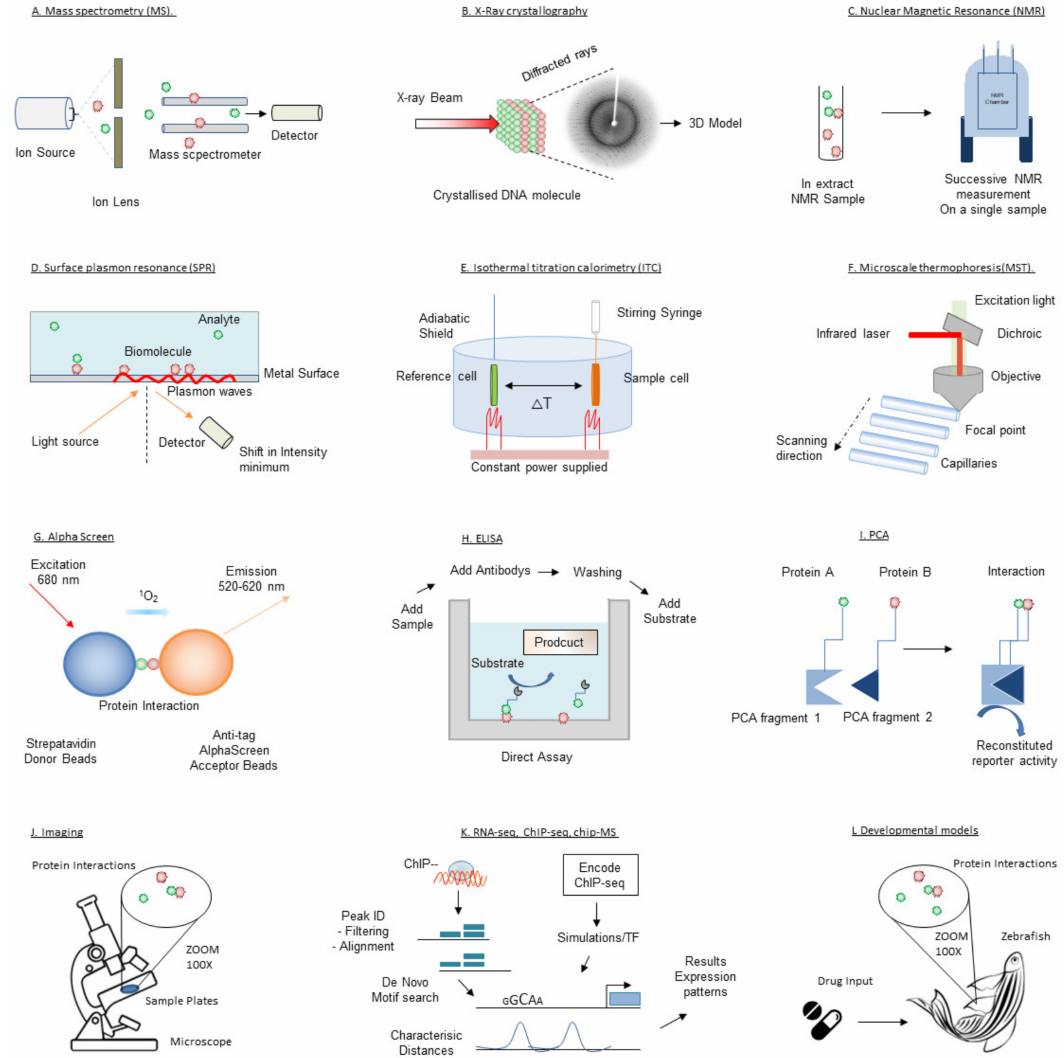
Figure 3. Schematic depiction of the techniques introduced in this